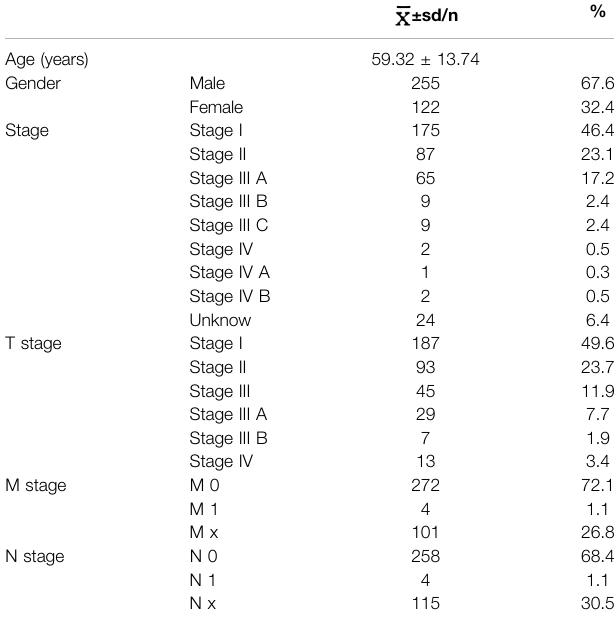
TABLE 1 | Clinical features of CRC patients from the TCGA database ( n =